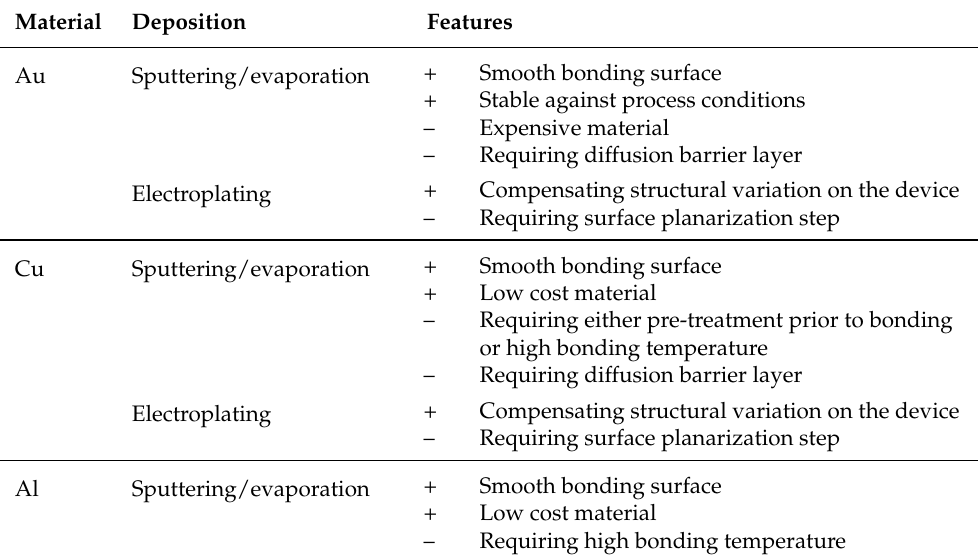
Table 1. Existing metal-based solid-state wafer bonding